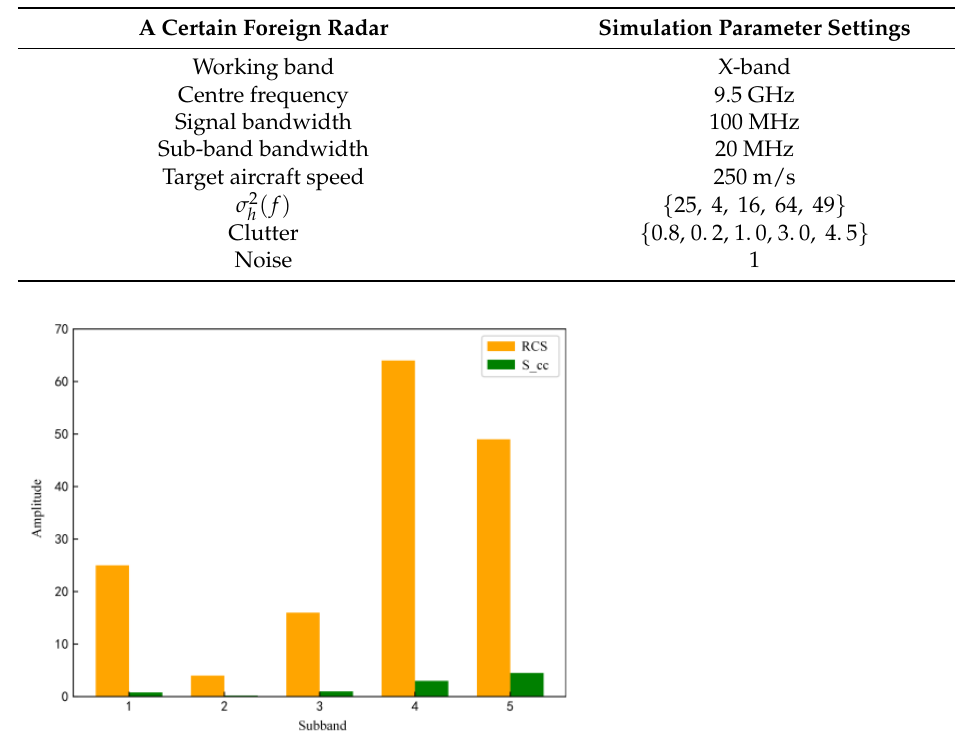
Table 3. Simulation parameters.